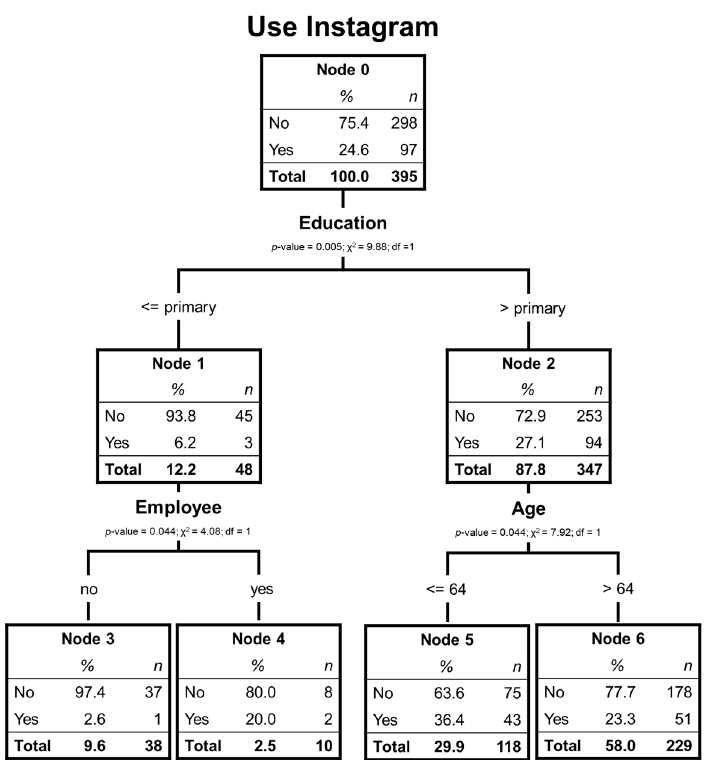
Figure 3. Decision tree of elderly Instagram users.